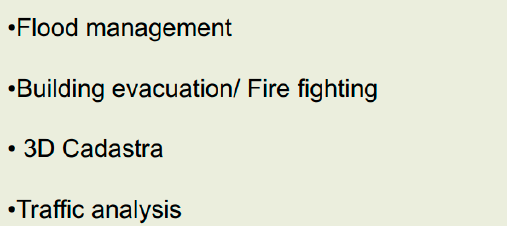
Figure 3. Practical example—essay question.